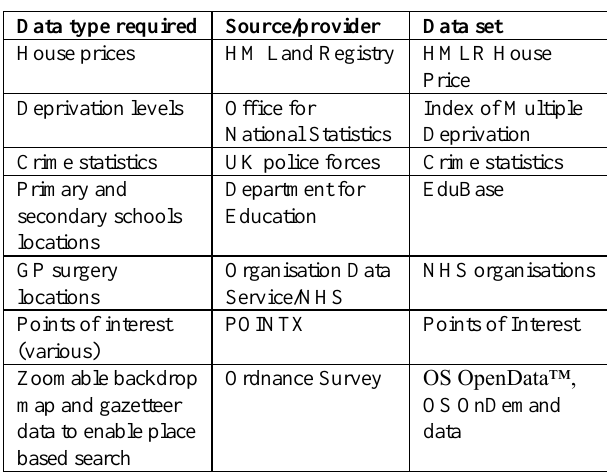
Table 1. Data required for the prototype and sources